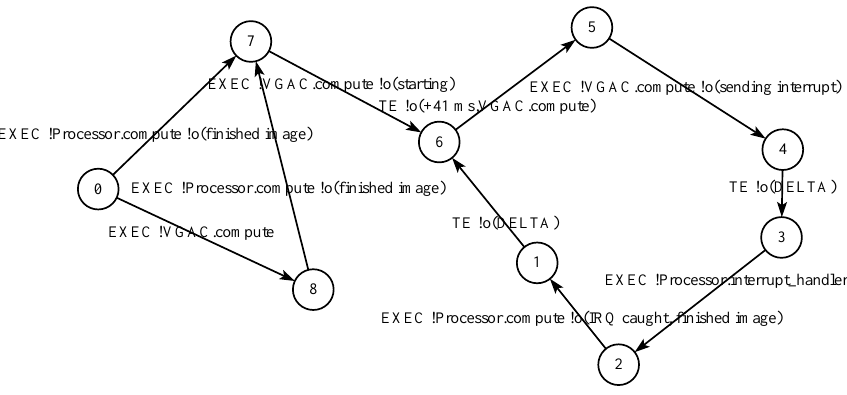
Figure 8 LTS generated for the basic system, after